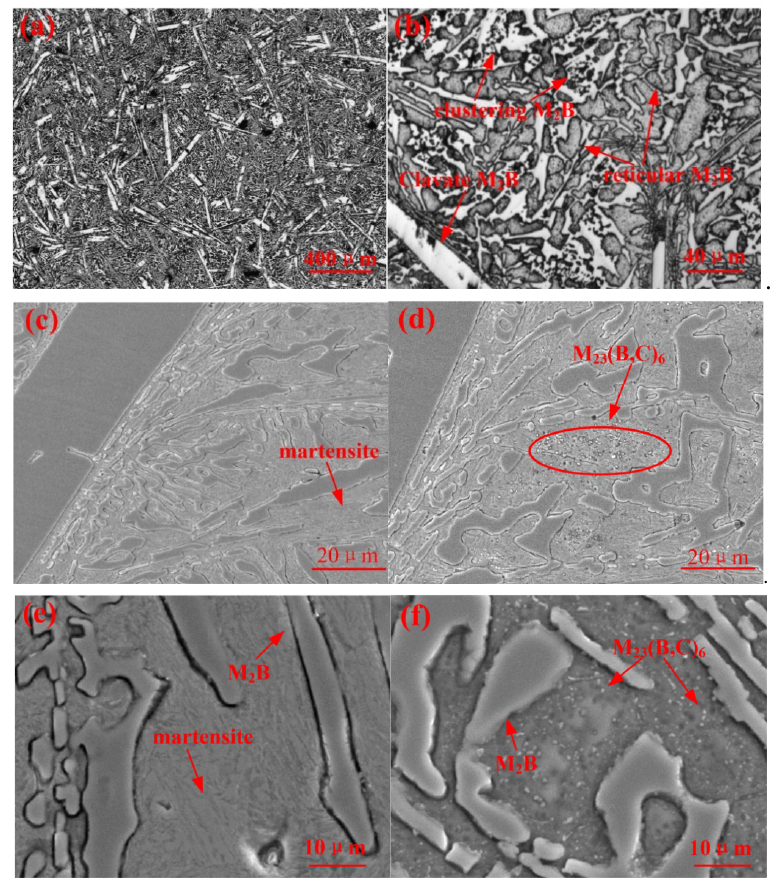
Figure 2. Microstructure of Fe-Cr-B-C alloy: ( a – c ) and ( e ) show the as-cast A1, while ( d , f ) show the heat-treated A2.